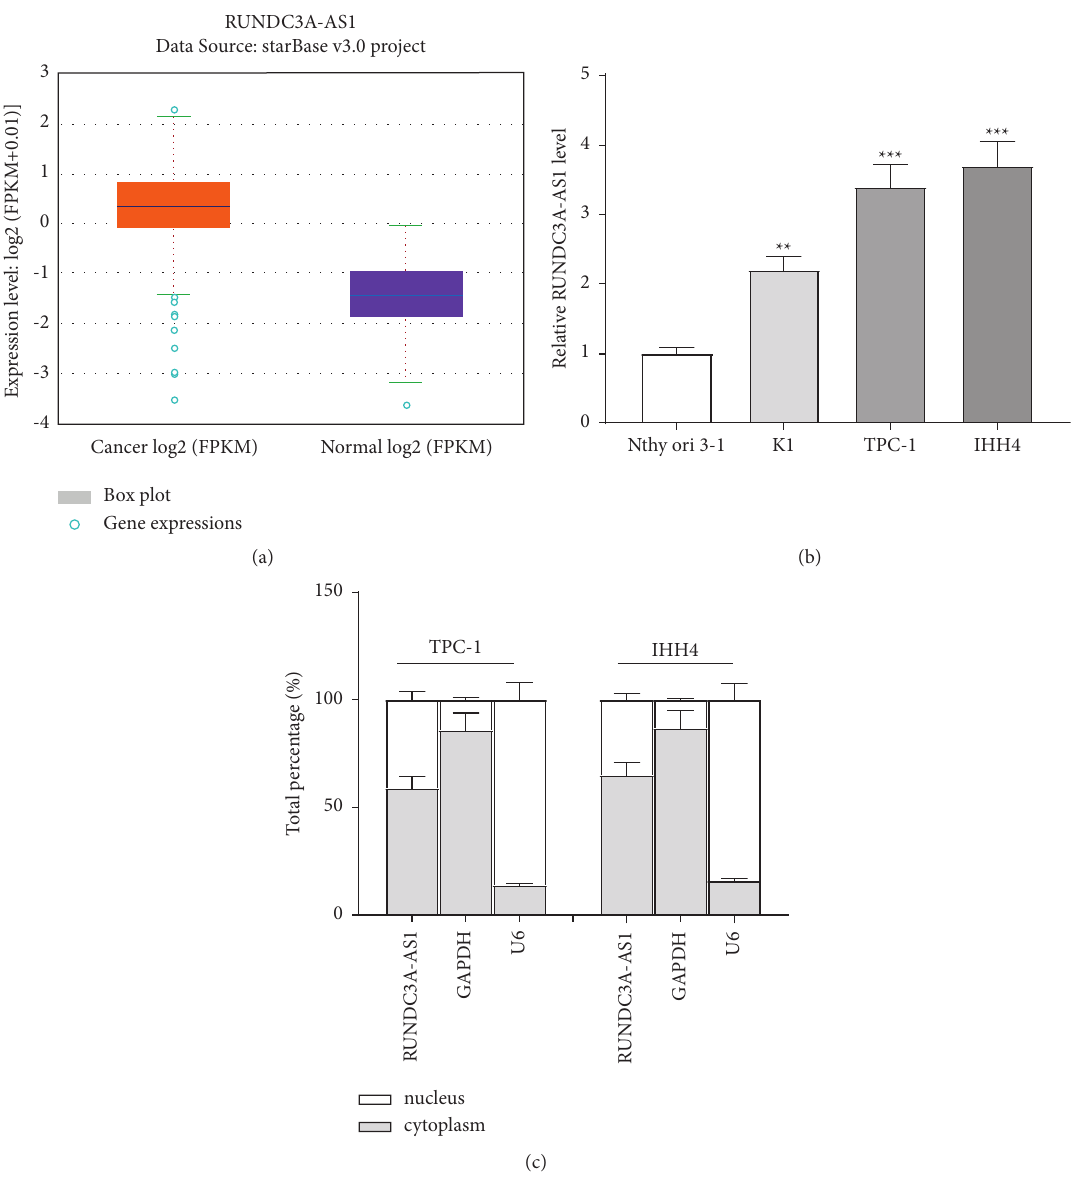
Figure 1: RUNDC3A-AS1 is highly expressed in THCA. (a) ENCORI showed the high expression of RUNDC3A-AS1 in THCA. (b) Expression of RUNDC3A-AS1 in K1, TPC-1, and IHH4 cell lines was examined by RT-qPCR. (c) The cytoplasmic and nuclear levels of RUNDC3A-AS1 in TPC-1 and IHH4 cells were analyzed by a subcellular fractionation assay. ∗∗ P < 0 . 01; ∗∗∗ P < 0 .